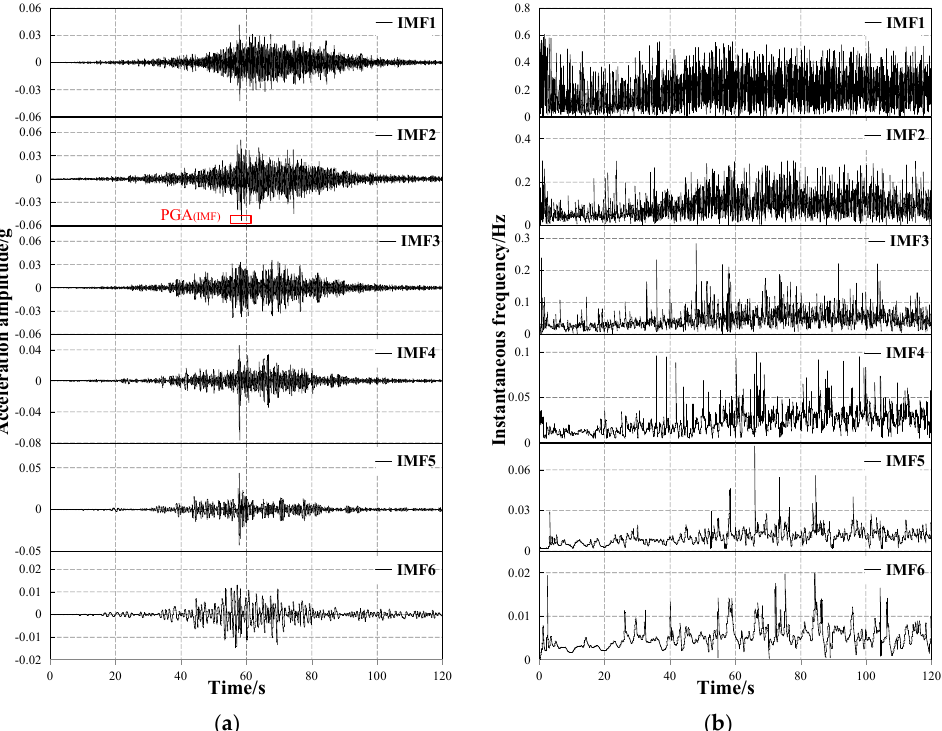
Figure 10. EMD results of the input WE wave (0.08 g): ( a ) IMFs 1–6, ( b ) the corresponding instanta- neous frequencies of the IMFs. Table 2. The PGA of the models when the WE wave was input in the x direction (0.08 g).